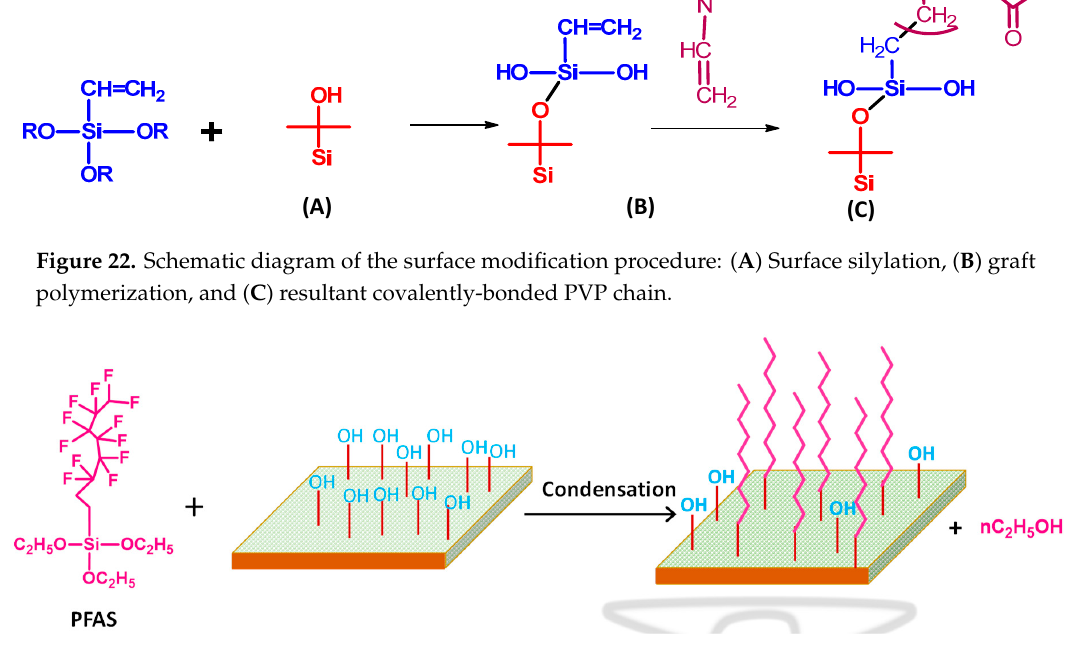
Figure 23. Scheme of modification process by PFAS molecules.